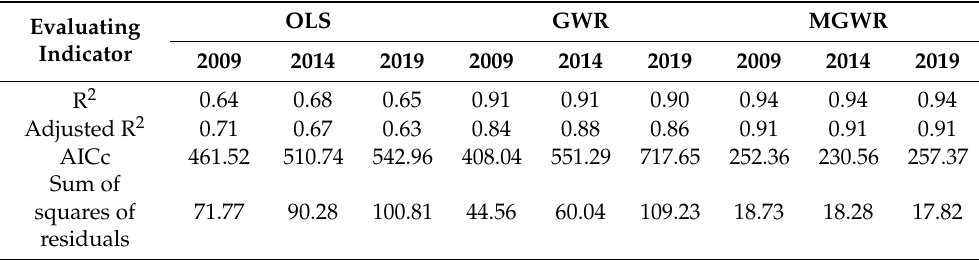
Table 3. Model metrics of OLS, GWR, and